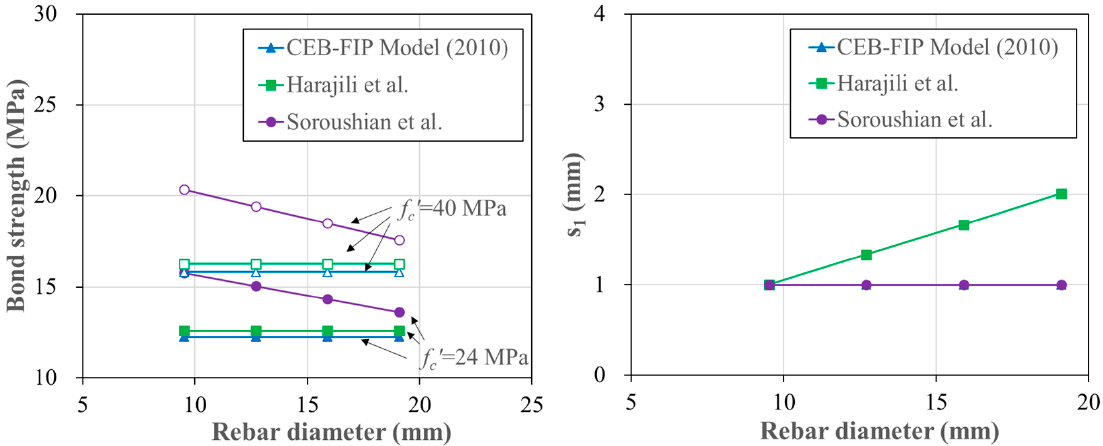
Figure 1. Comparison of the previous models on the bond strength and the slip corresponding to the bond strength